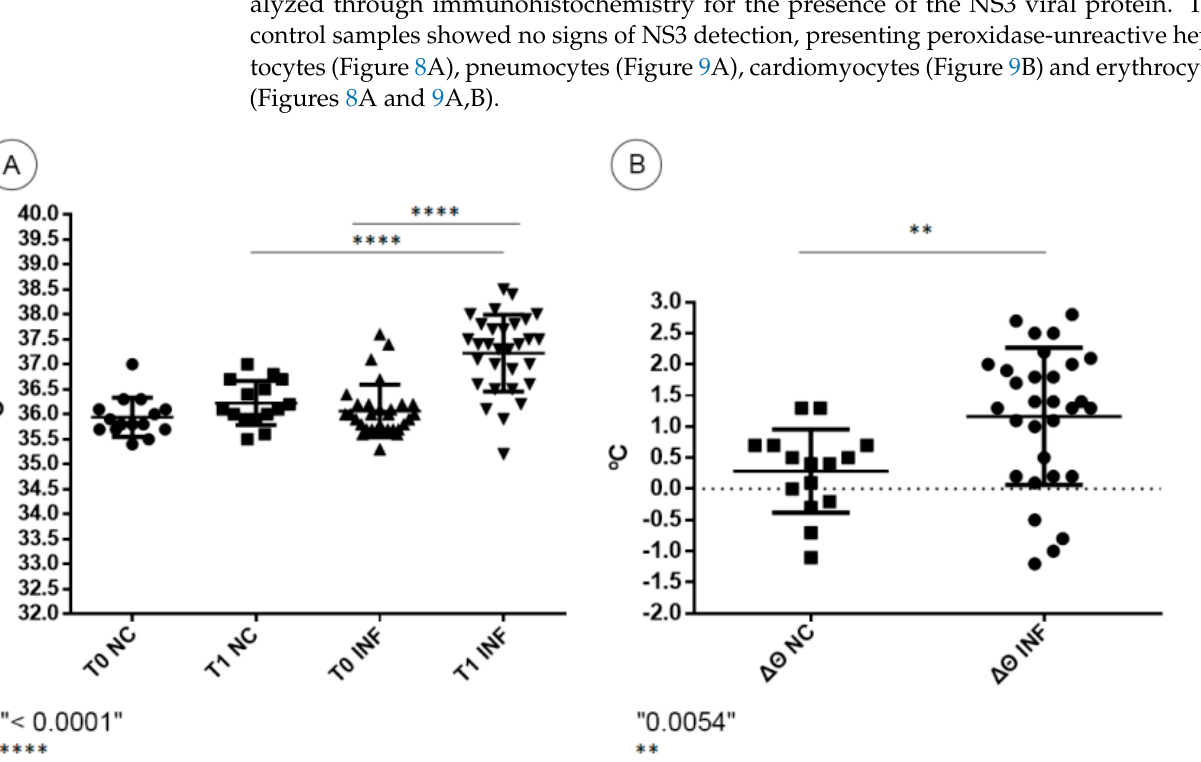
Figure 1. ( A ) Temperature values at pre-infection time (T0) and 72 h post-infection (T1) of negative control (NC) and DENV-4-infected BALB/c mice (INF). ( B ) Temperature variation between T0 and T1 ( Δ ϴ ) of negative control (NC) and DENV-4-infected BALB/c mice (INF).